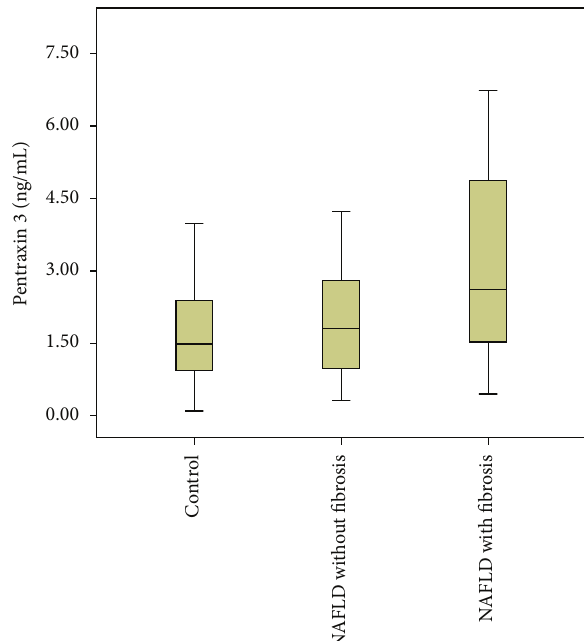
Figure 1: Pentraxin 3 concentrations (ng/mL) in the plasma of NAFLD patients with fibrosis ( 𝑛 = 21 ), NAFLD patients without fibrosis ( 𝑛 = 33 ), and healthy controls ( 𝑛 = 20 ). 𝑃 = 0.903 for control versus NAFLD without fibrosis, 𝑃 = 0.028 for control versus NAFLD with fibrosis, and 𝑃 = 0.032 for NAFLD with fibrosis versus NAFLD without fibrosis. Pentraxin 3 levels were less than 2ng/mL (cutoff) in both NAFLD patients without fibrosis and control